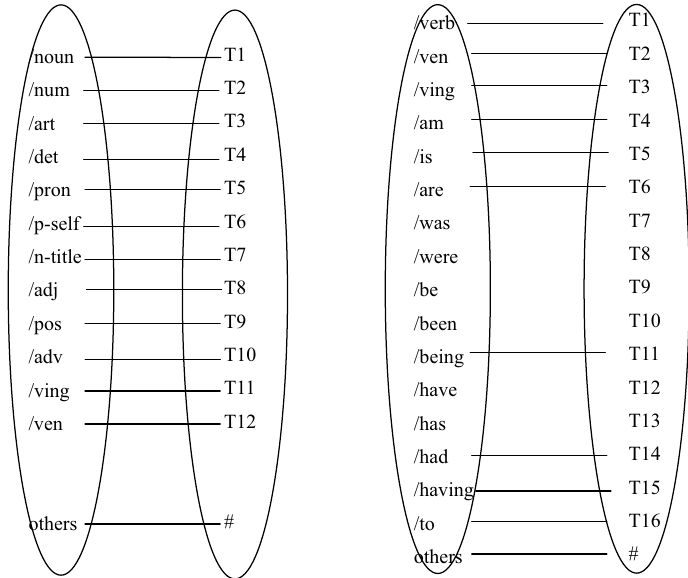
Figure 4: The symbolic mapping from the system terminator to the analysis table